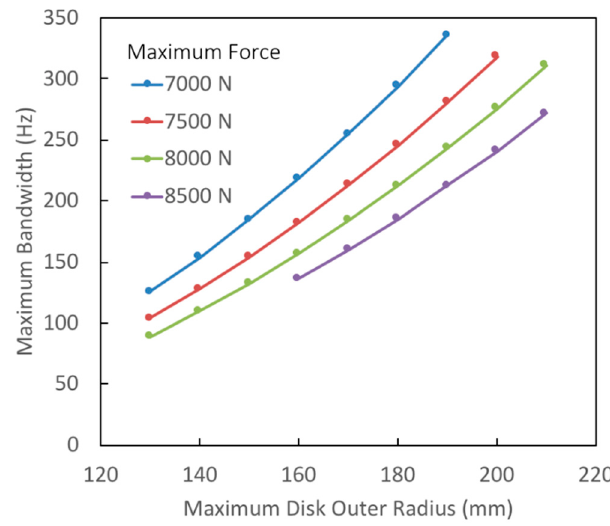
Figure 3. Pareto-optimal curves showing maximum achievable actuator bandwidth as a function of the maximum allowable disk outer radius for various values of maximum force.